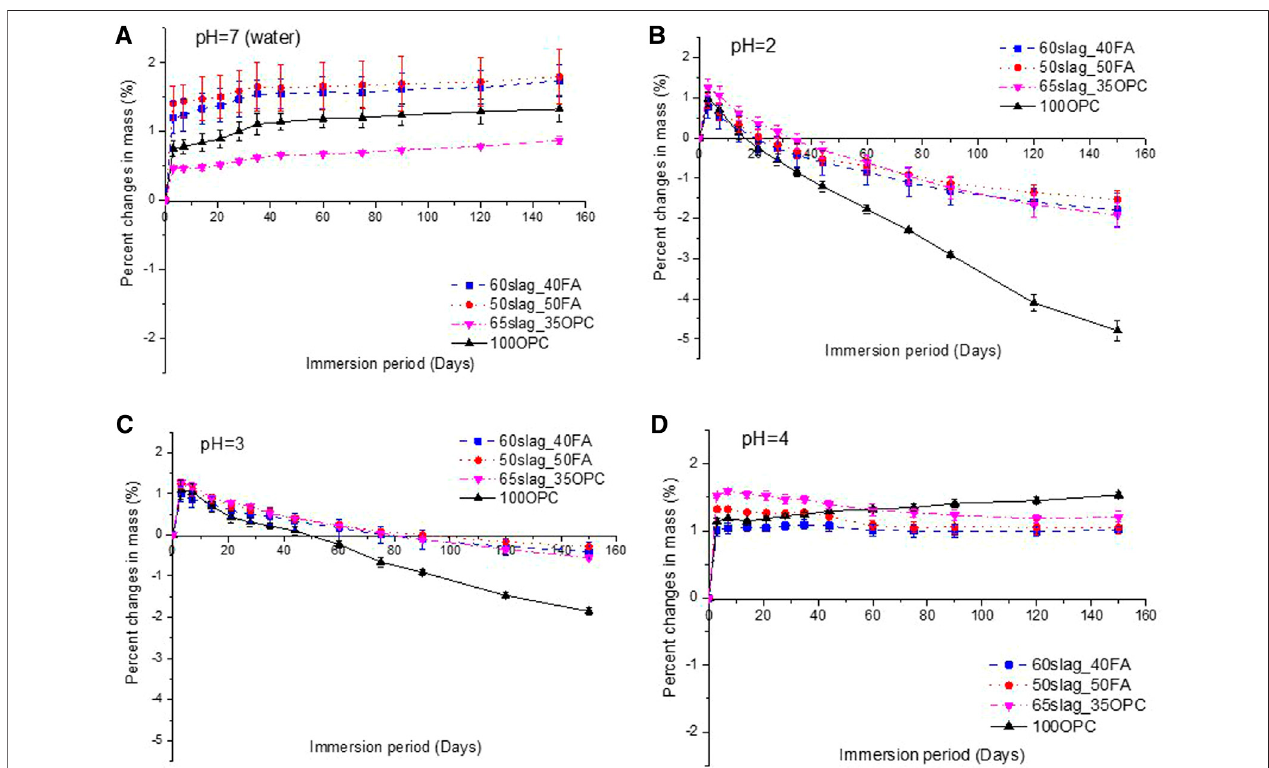
FIGURE4| Masschangesofmortarsover150-dayimmersioninwater(pH=7) (A) andinphosphoricacidwithpH=2 (B) ,pH=3 (C) andpH=4 (D) .Positiveand negative values indicate mass gain and loss, respectively.